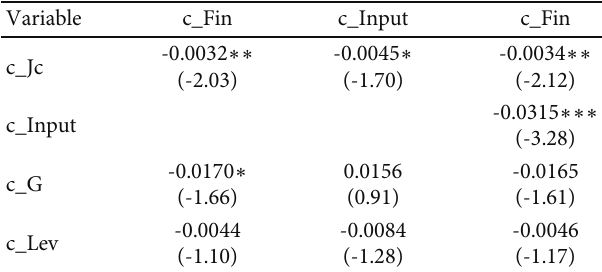
Table 3: Regression results of productive investment ratio as an intermediary variable.